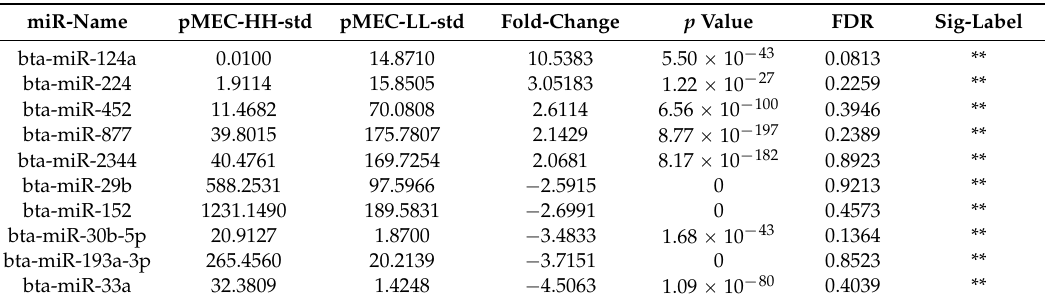
Table 3. 10 greatest fold change miRNAs between the two pMECs.